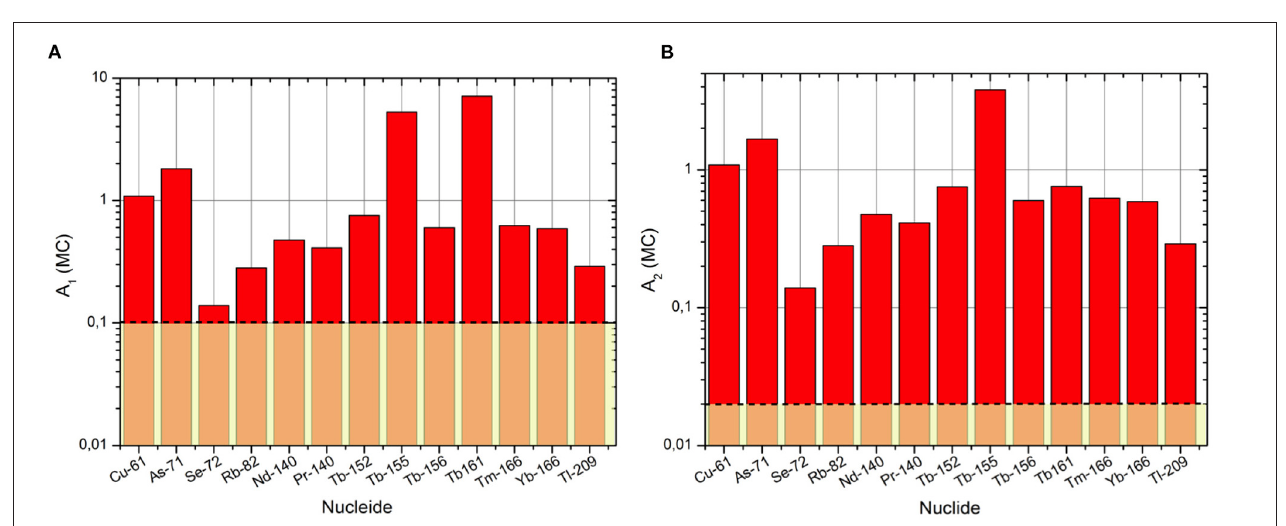
FIGURE 6 | Ratio between the simulated values and the tabulated ones for A 1 (A) and A 2 (B) for the isotopes in the control group.